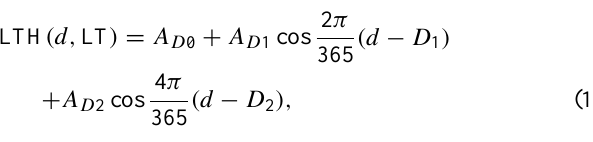
Figure 6. Contour of the calculated LTH versus day of year and local time under F107=100 and Ap=10.